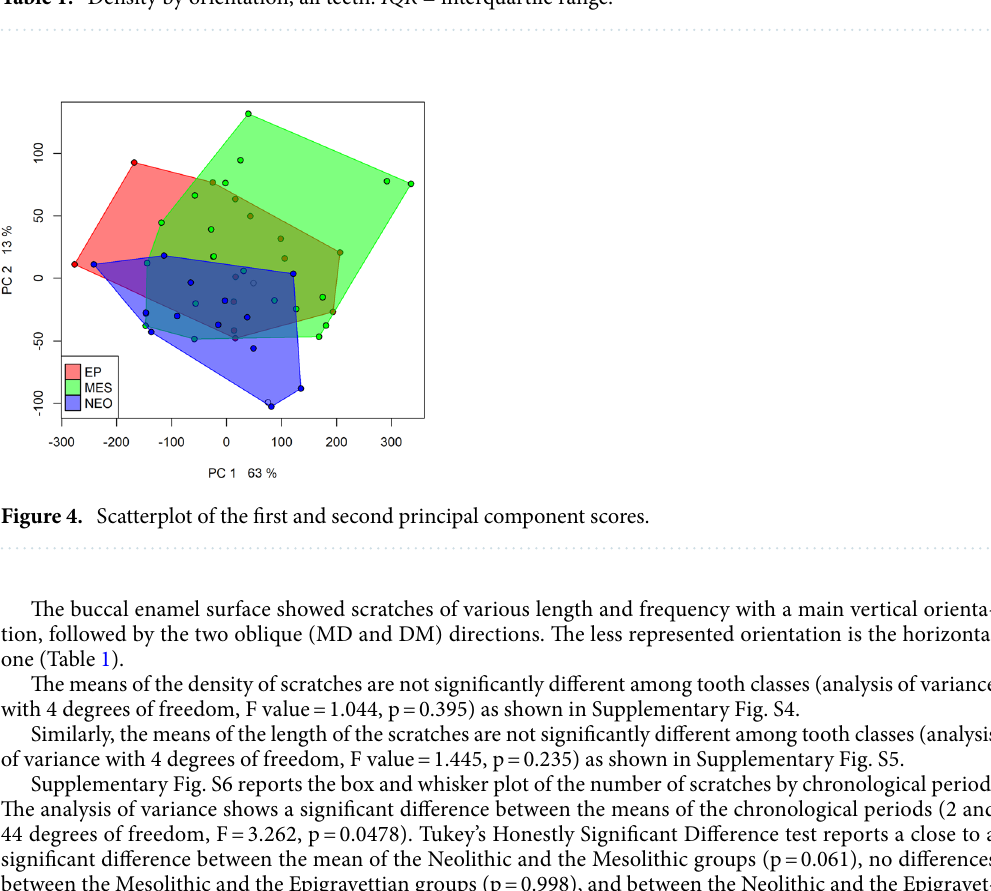
Table 1. Density by orientation, all teeth. IQR = interquartile range.